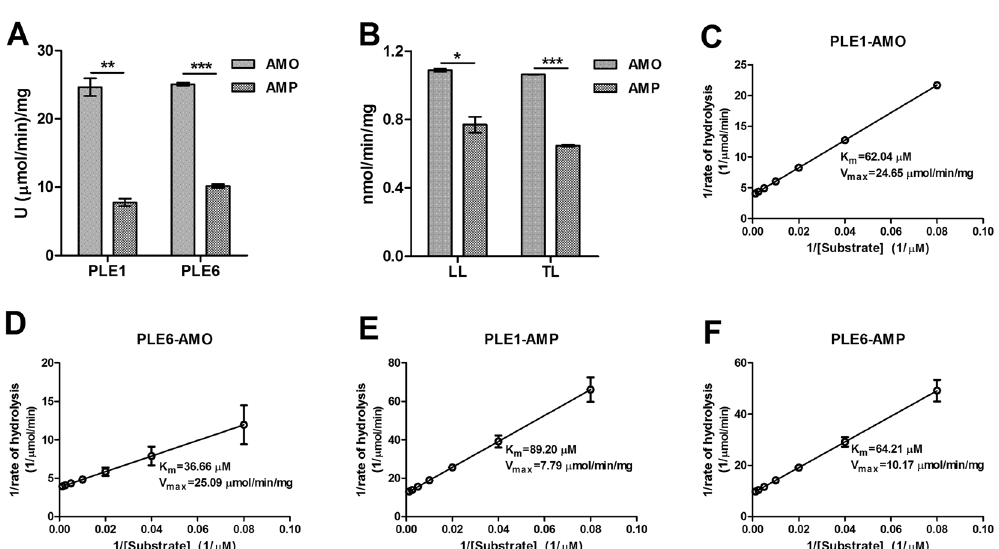
Figure 4. Hydrolysis of AMO/AMP by PLE1, PLE6 and liver S9 fractions and determination of enzyme kinetics. ( A , B ) LC-MS/MS detection of the hydrolytic activities of recombinant PLEs and liver S9 fractions toward AMO/AMP. ( C–F ) Line weaver-Burk plot of AMO/AMP hydrolysis by recombinant PLEs. K m and V max were calculated by Visual Enzymics. All assays were performed in triplicate with three experiments and the hydrolytic activities are expressed as the mean ± S.D. The asterisk sign denotes statistical significance ( * P < 0.05; ** P < 0.01; *** P <